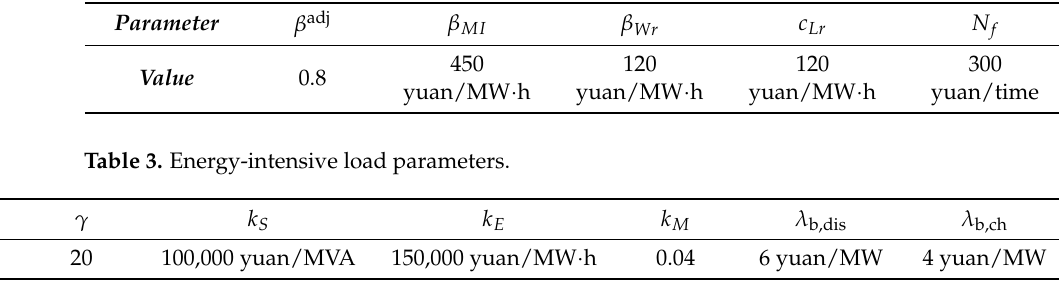
Table 2. Energy-intensive load parameters.